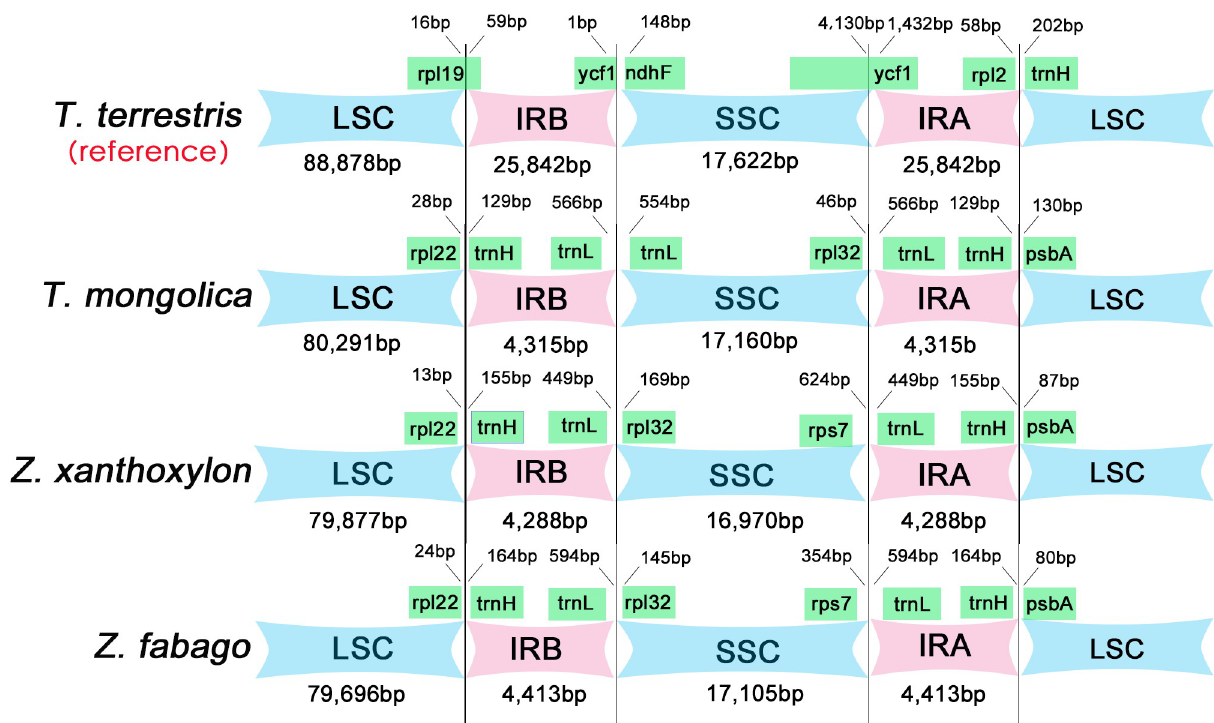
Fig 10. IR expansion and contraction in three chloroplast genomes. Gene names are shown in boxes, and genes lengths in the corresponding regions are marked above the boxes. These features are not to scale.